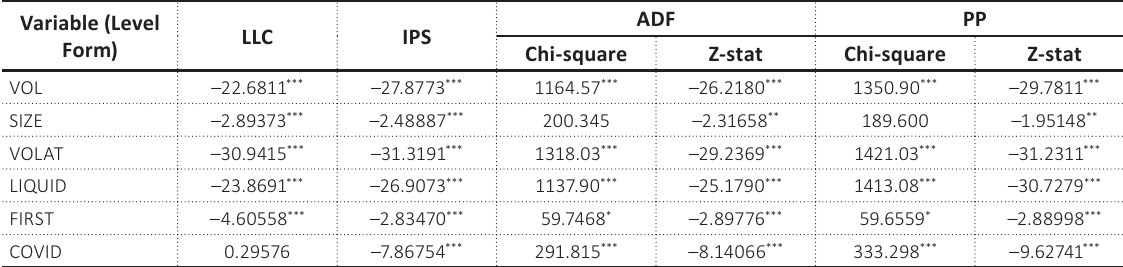
Table 5. Panel unit root tests Variable